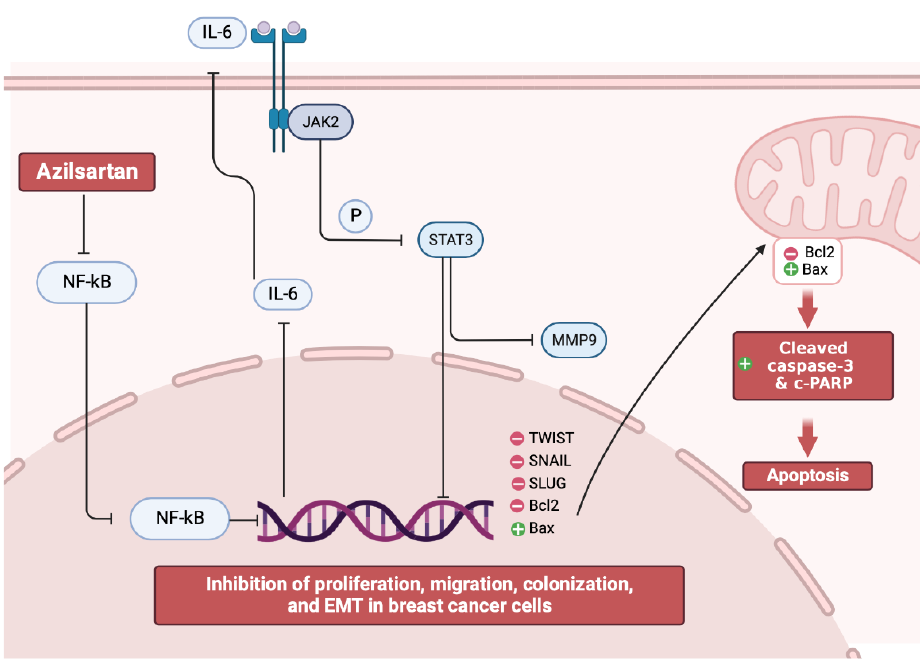
Figure 11. Illustrative figure summarizes the molecular mechanism of the anti-proliferative, EMT inhibition, and apoptotic activities of azilsartan against breast cancer cells.